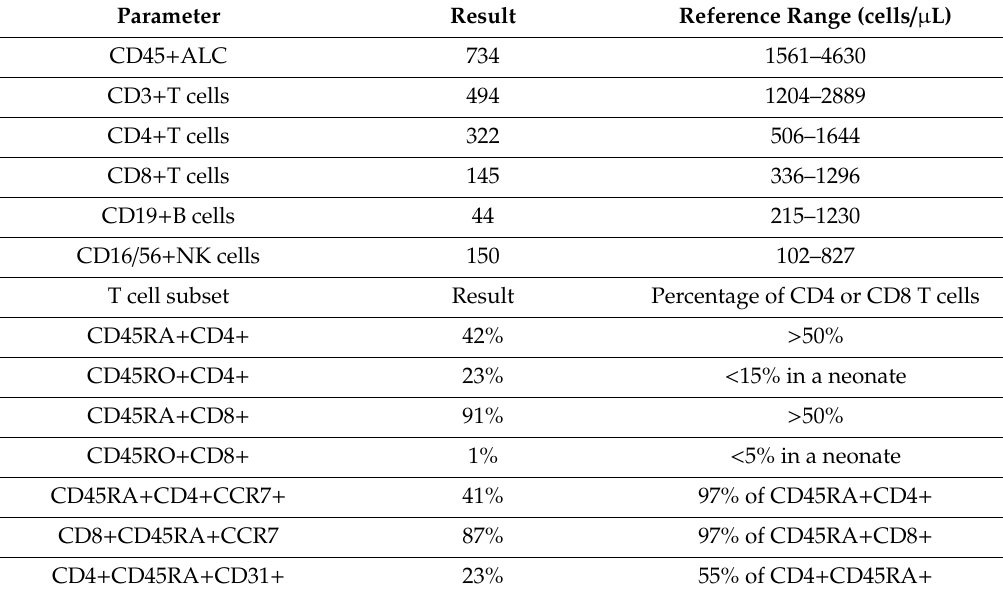
Table 4. Case 2, lymphocyte subset